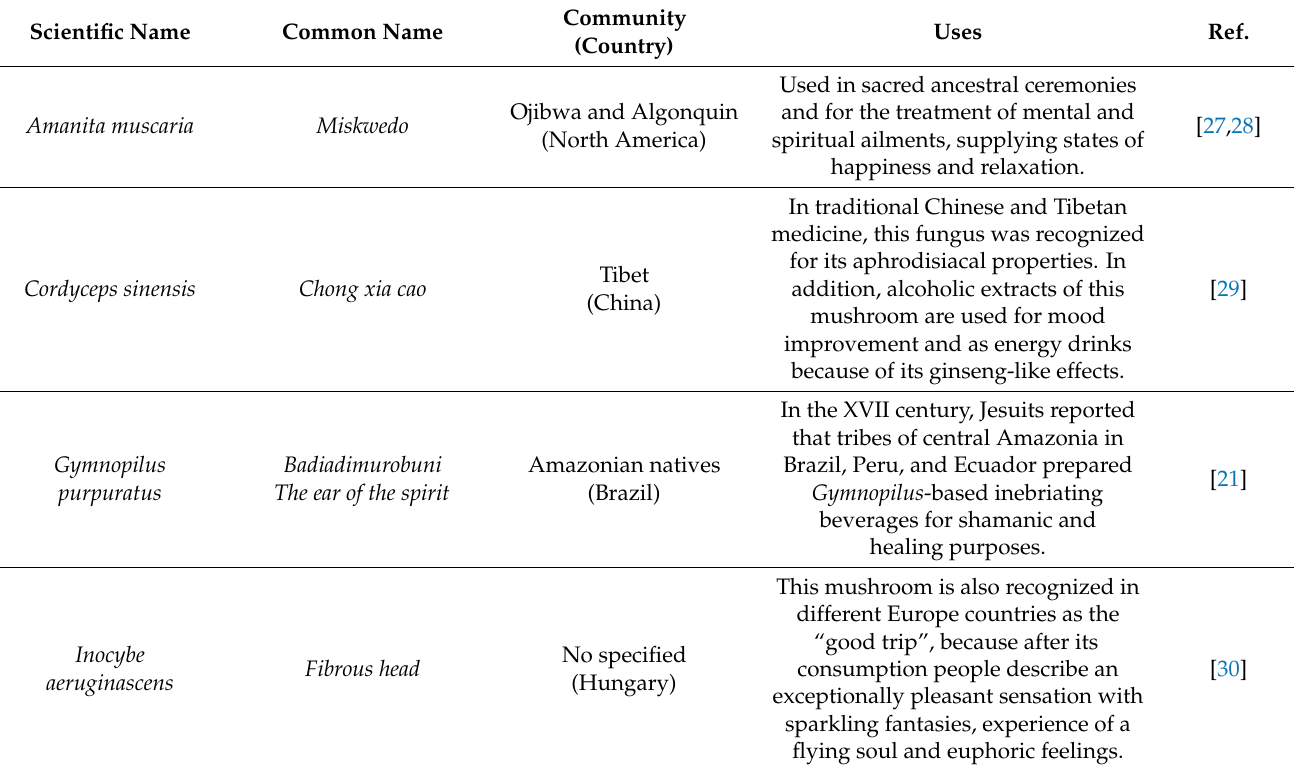
Table 1. Selected examples of psychoactive mushrooms with ethnopharmacology relevance around the